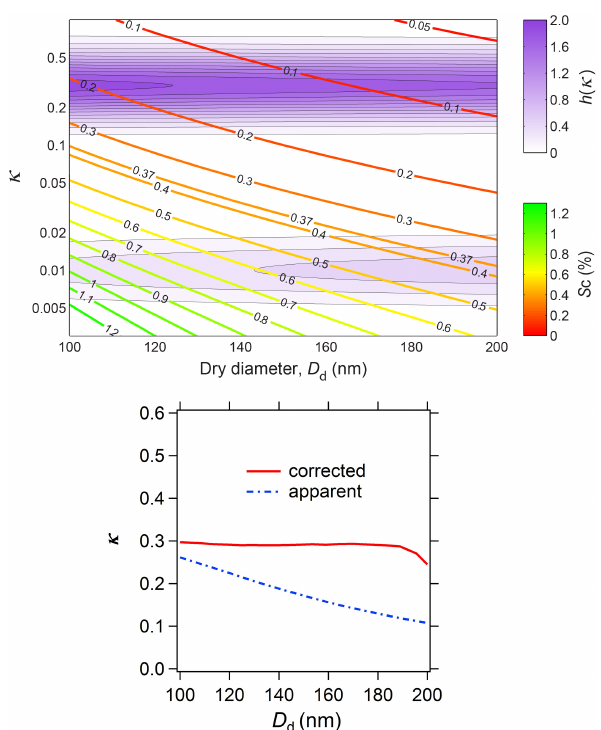
Figure 5. (a) Supersaturation required to activate the less hygro- scopic mode by the DMT-CCNC. The shaded isolines show the nor- malized size-resolved hygroscopicity distribution h(κ) , the proba- bility density function of a two-mode κ distribution (Rose et al., 2011). The colored isolines represent the supersaturation required to activate particles for a certain dry diameter D d and κ . (b) Model simulations of κ retrieved for the more hygroscopic mode by BS2- CCNC with (labeled as “corrected”) and without (labeled as “ap- parent”) complementary measurements of the